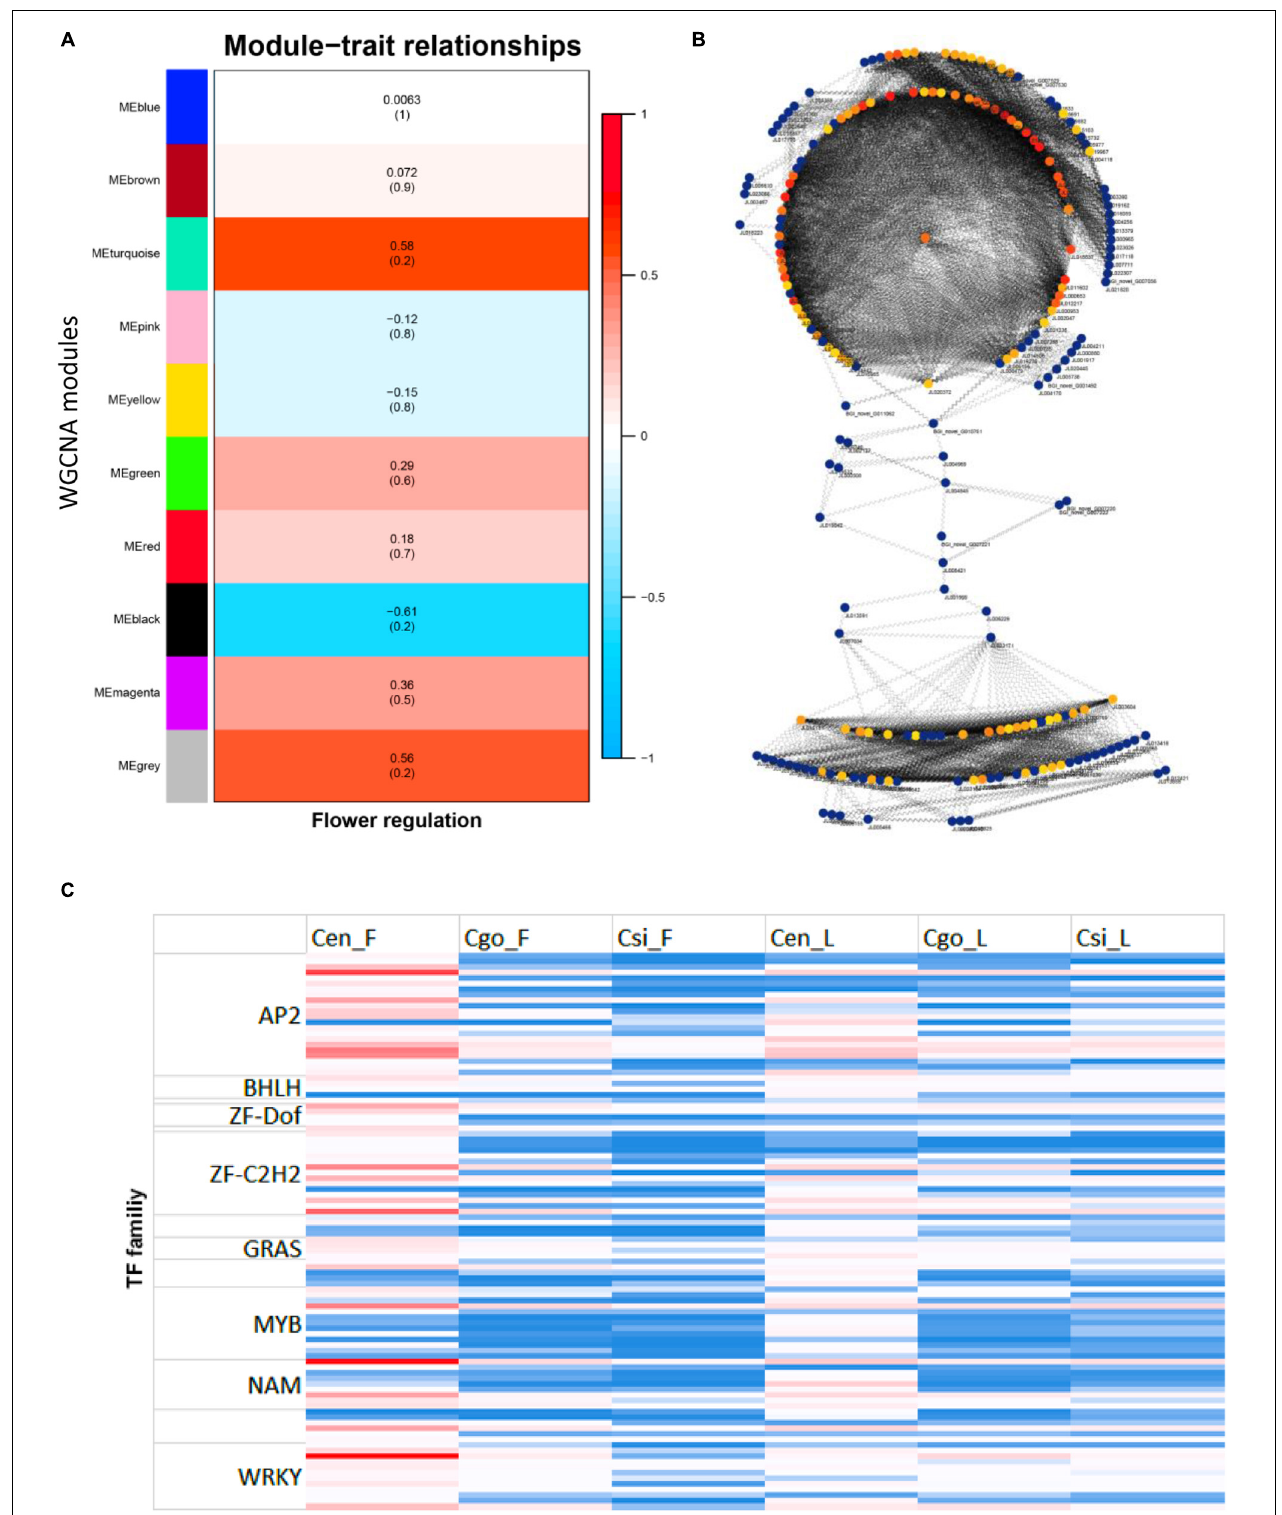
FIGURE 6 | Identification of modules through the weighted gene coexpression network analysis (WGCNA) (A) ; interaction network by modules (B) , the color intensity shows the level of connectivity (red for high connectivity and yellow for low connectivity); and the abundance of TF families for top 100 highly connected TFs identified from modules (C)